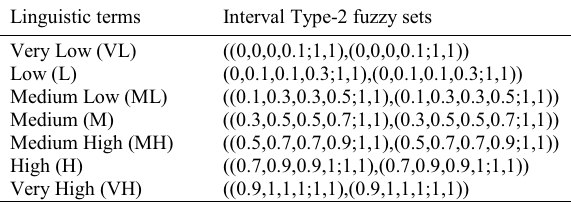
Table 2. Linguistic ratings and corresponding IT2FSs 79